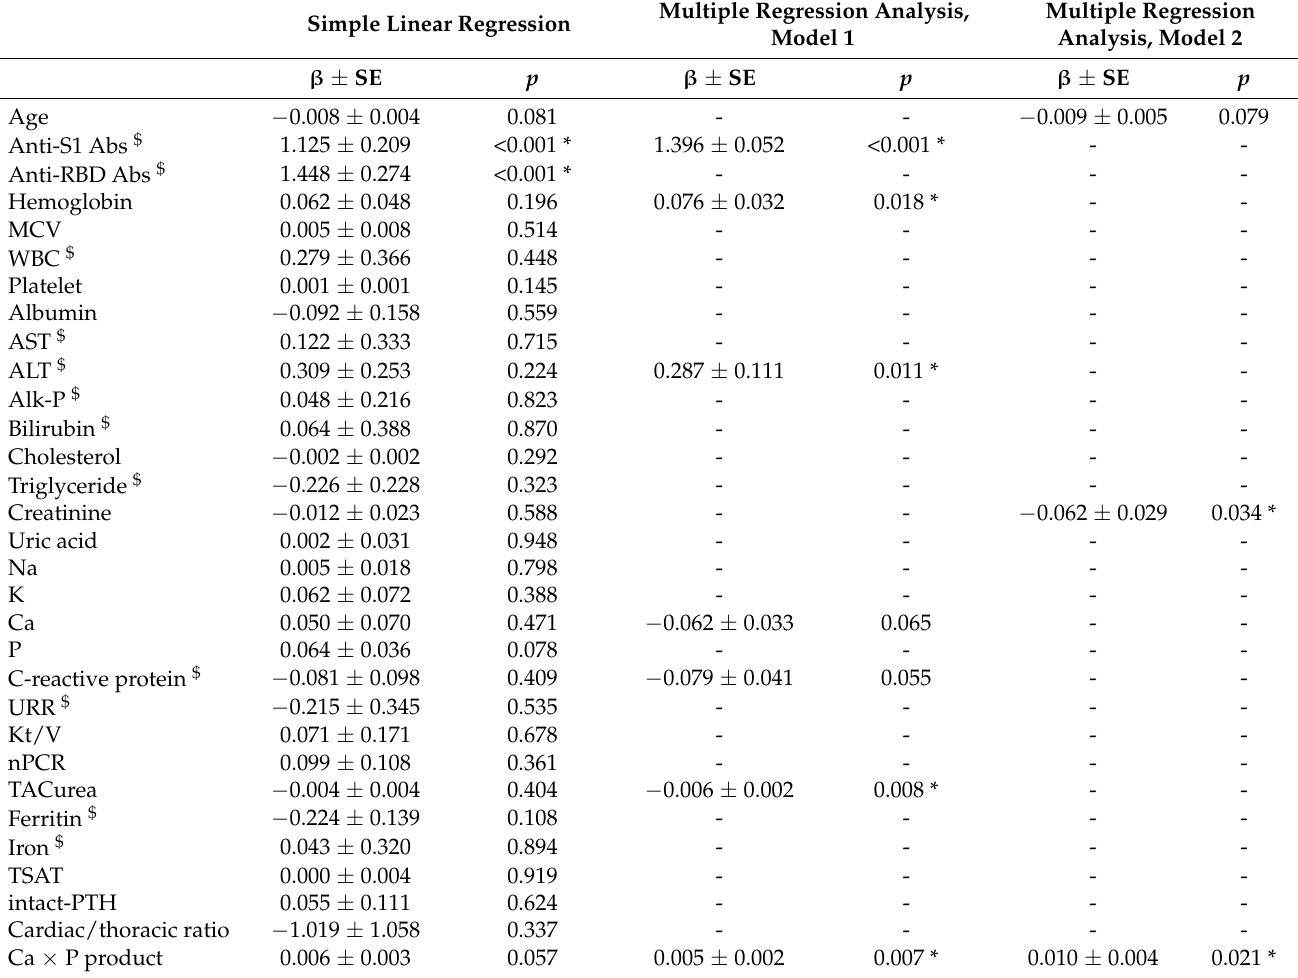
Table 3. β -coefficient between NT 50 and independent variables.